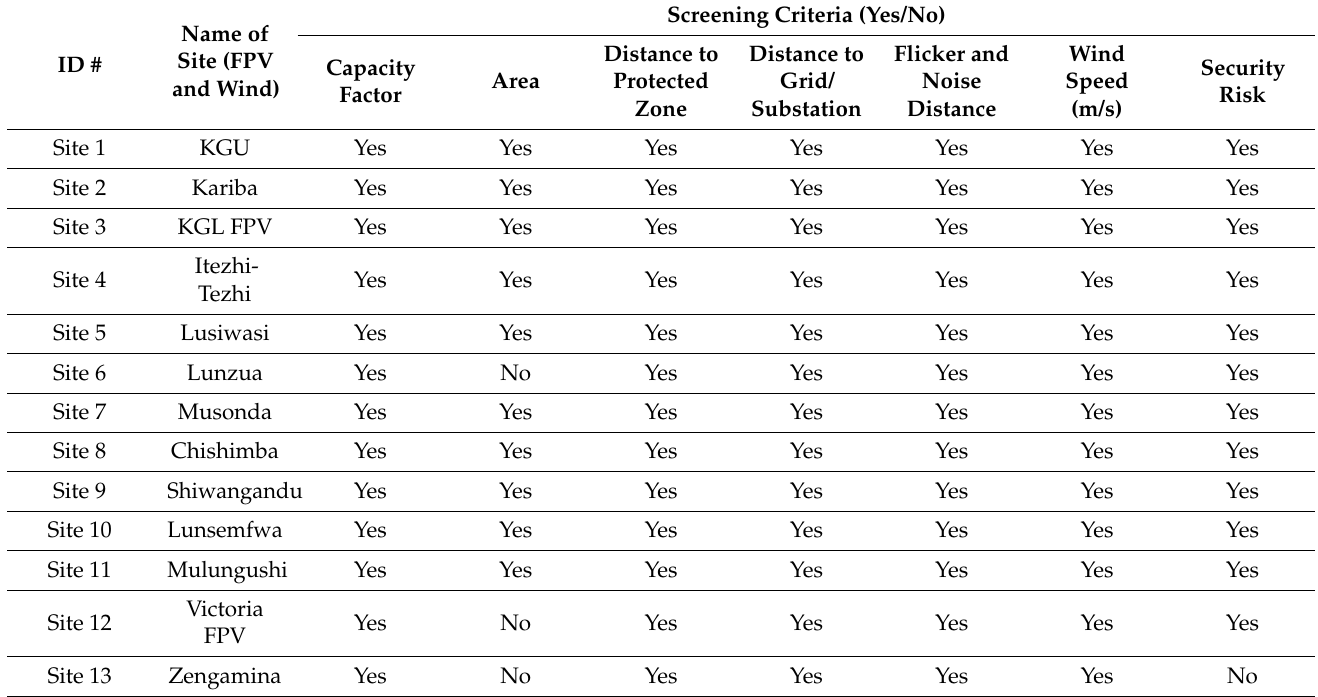
Table 3. Table showing the combined stage 1 screening outcome for both FPV and onshore wind